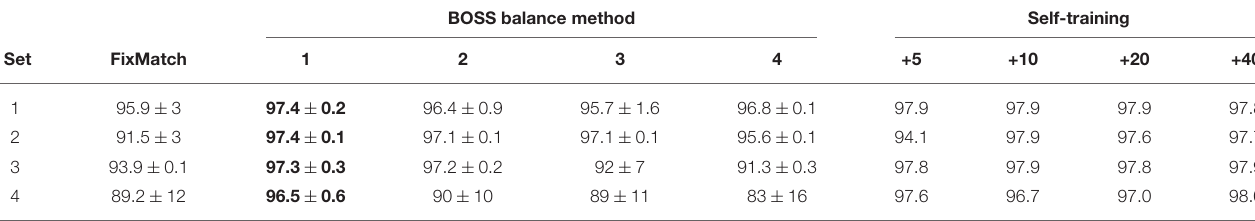
BOSS balance method Self-training